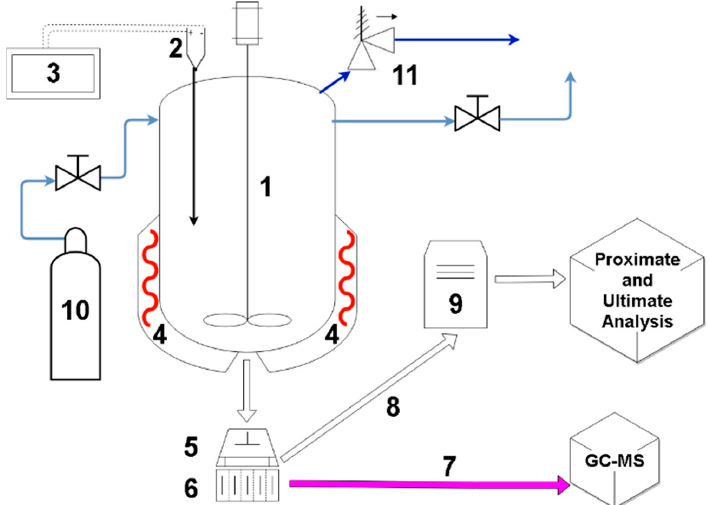
Figure 1. Diagram of the test rig, used for hydrothermal carbonization of the digestate (1—autoclave;